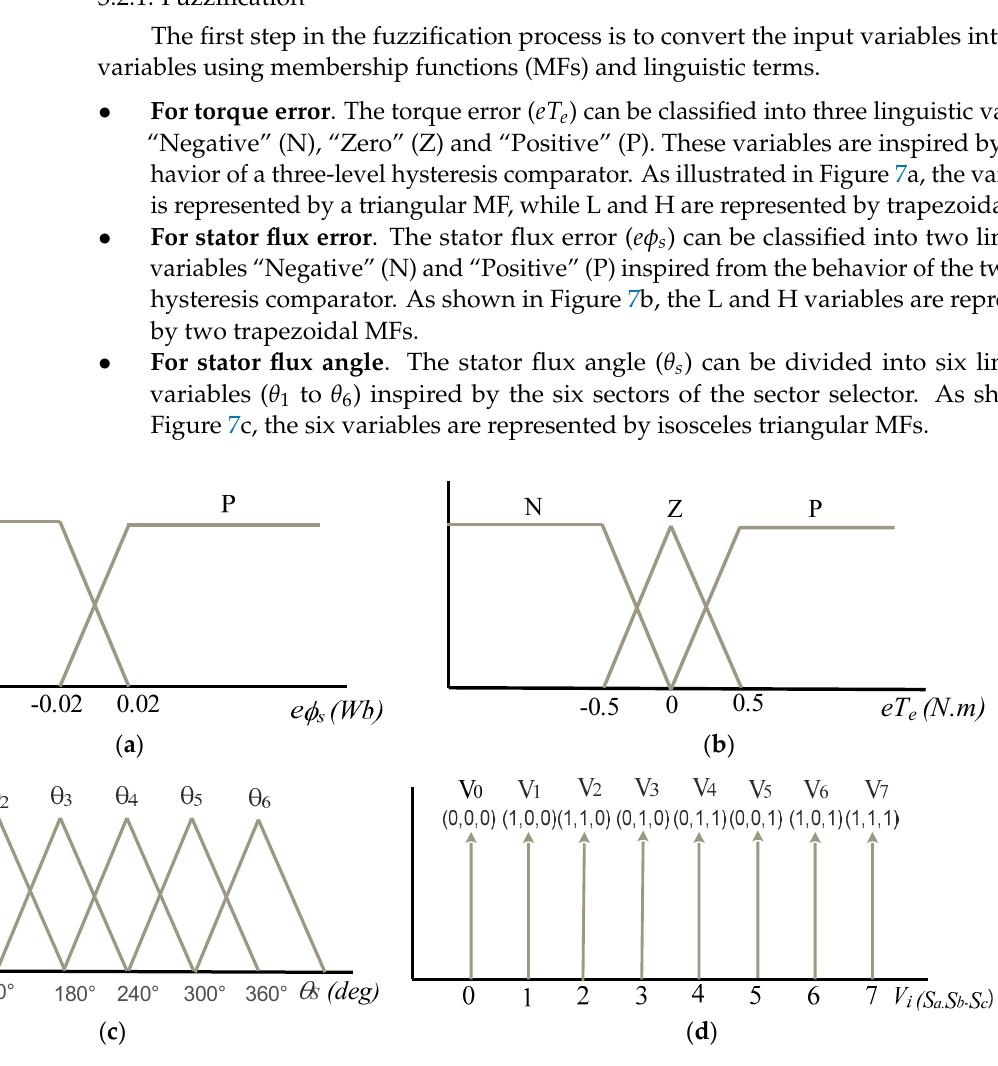
Figure 7. Mamdani-type membership functions ( a ) stator flux error input; ( b ) electromagnetic torque error input; ( c ) stator flux angle input; ( d ) stator voltage vectors output.